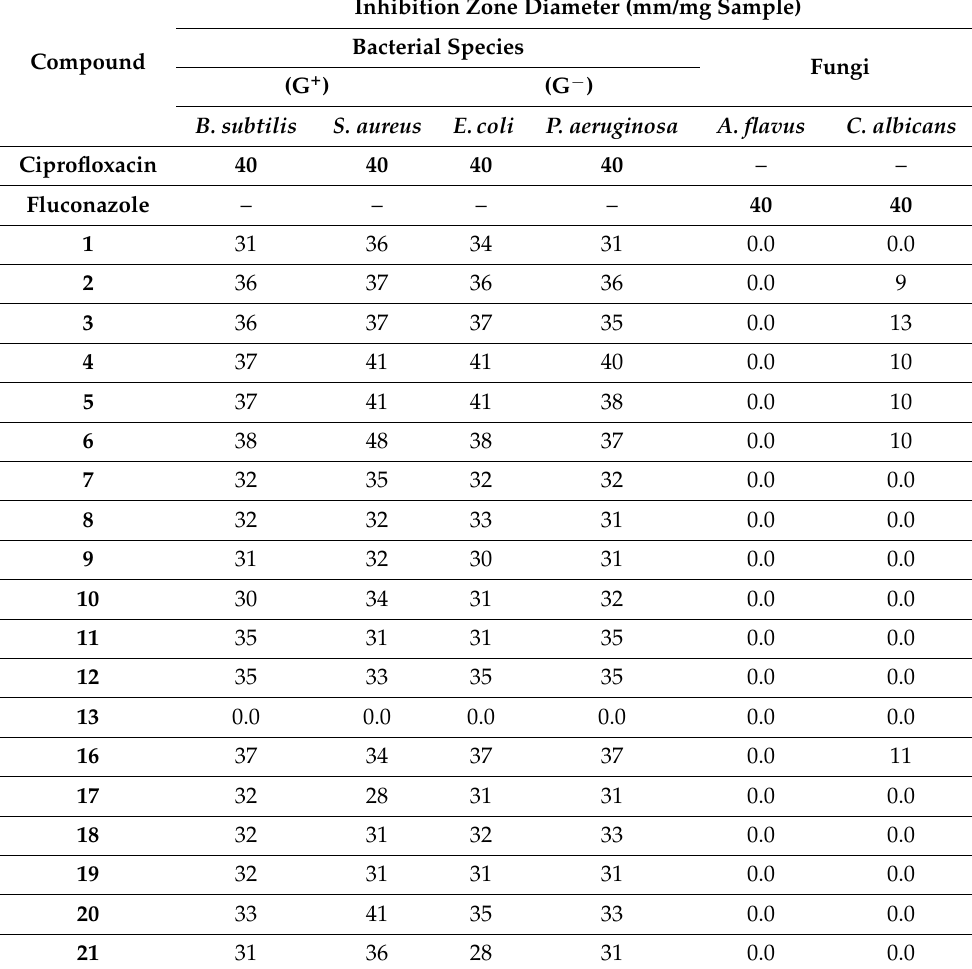
Table 1. Inhibitory zone diameter (mm) of compounds 1–21